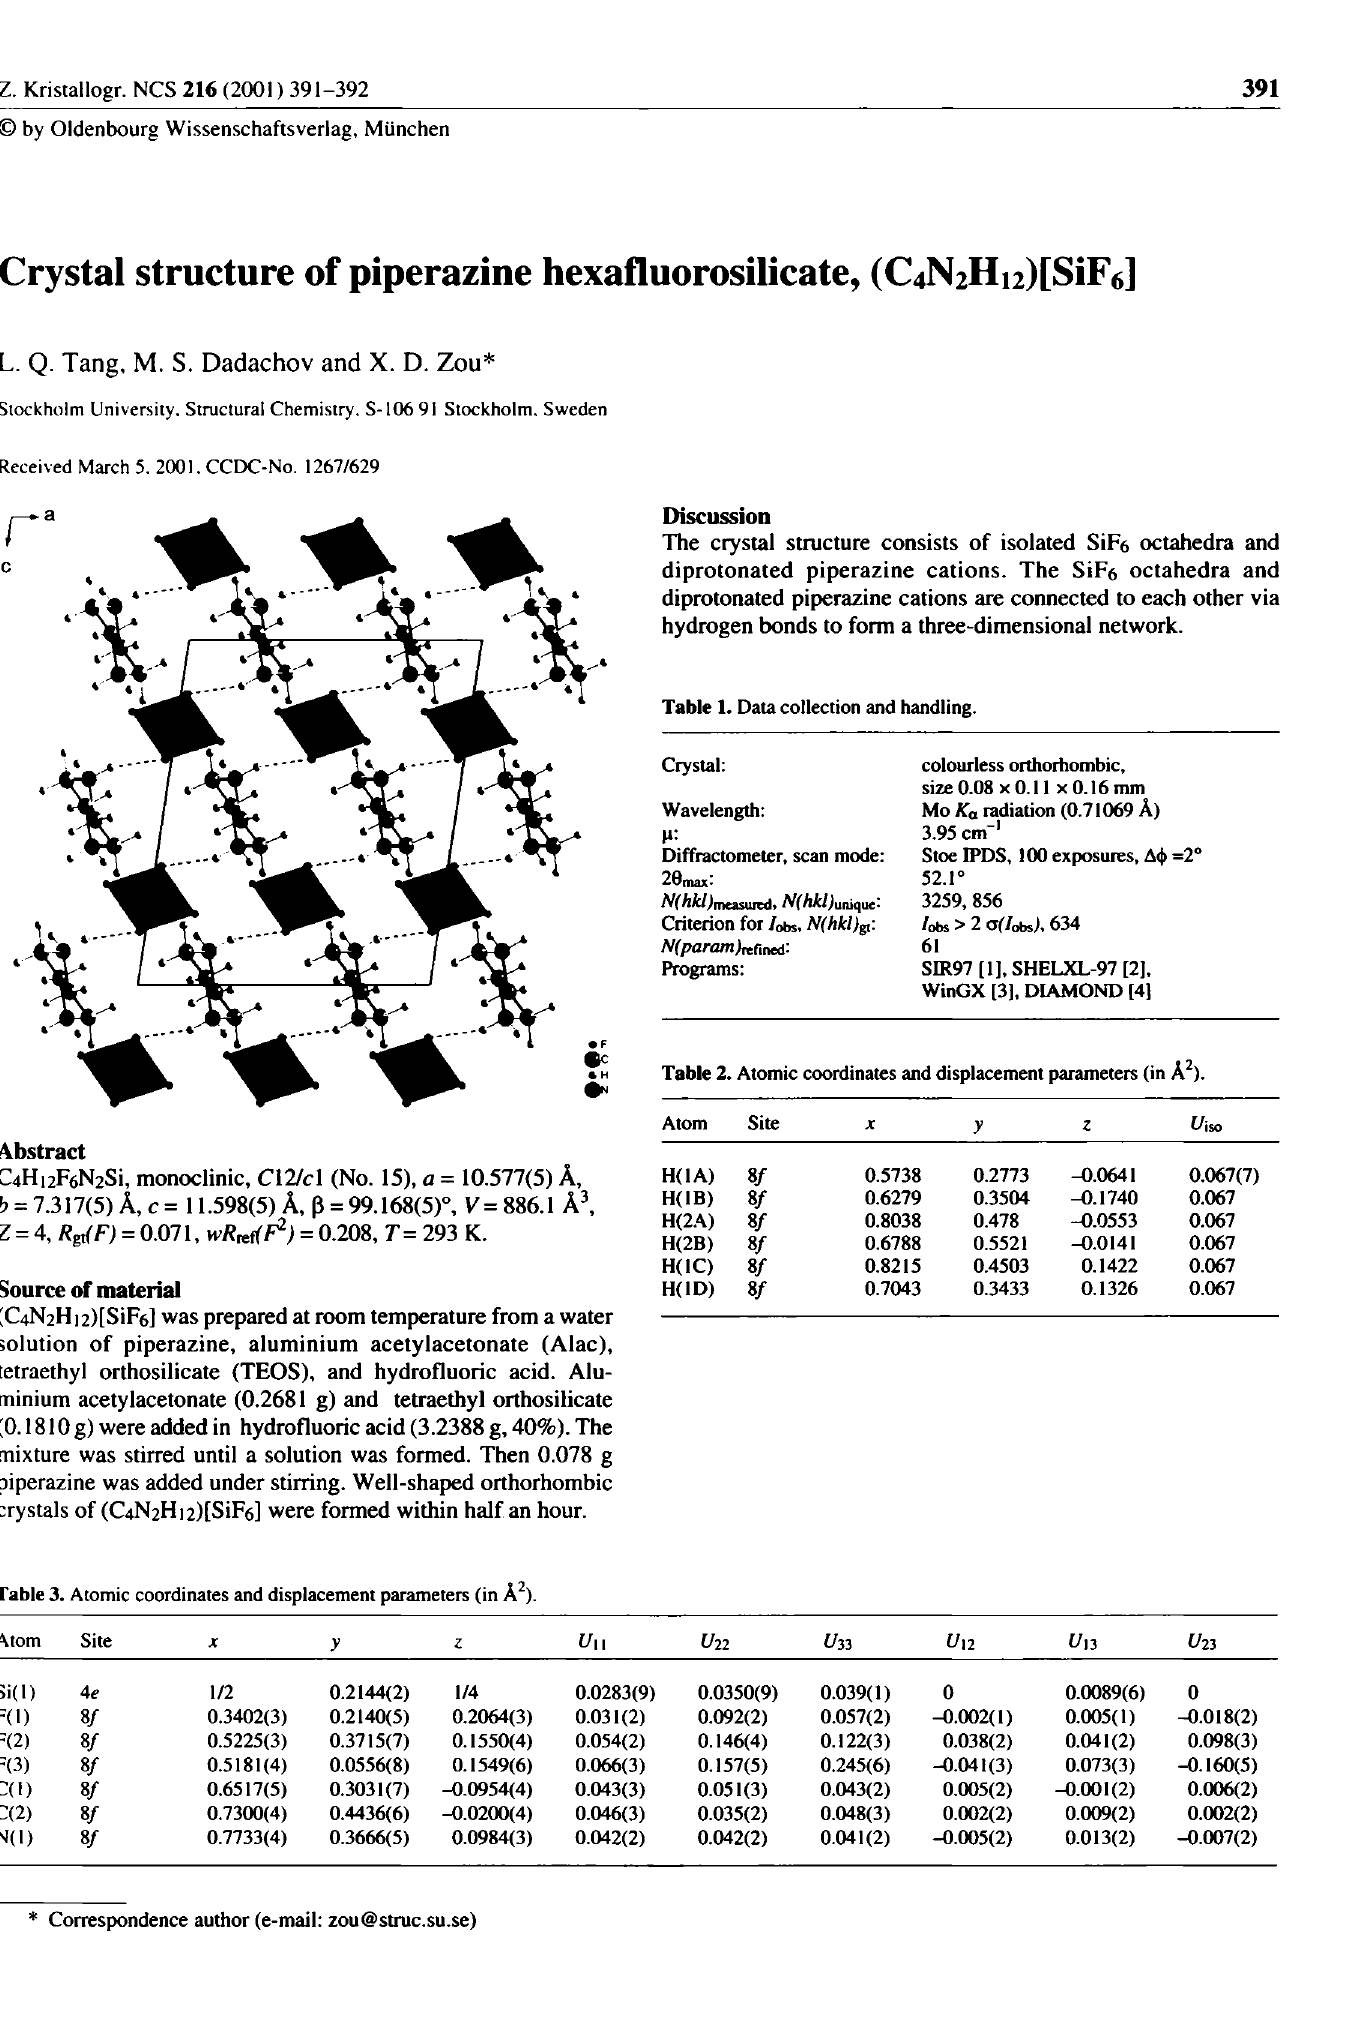
Table 3. Atomic coordinates and displacement parameters (in A 2